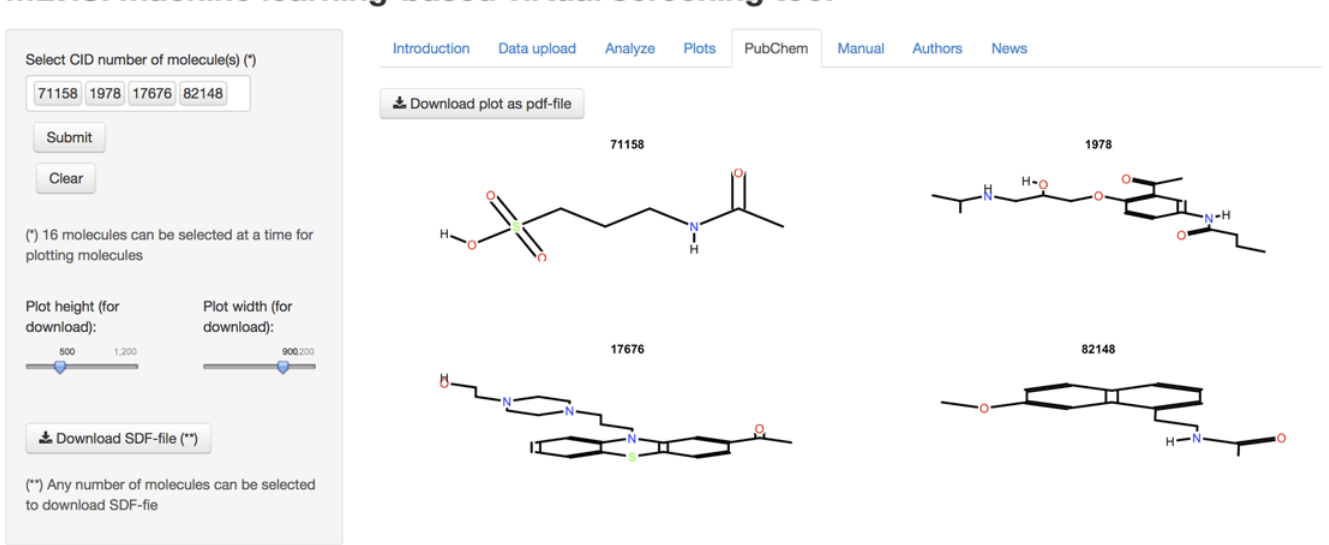
Fig 6. PubChem tab of the MLViS web-tool. Users can create and view molecular structures of